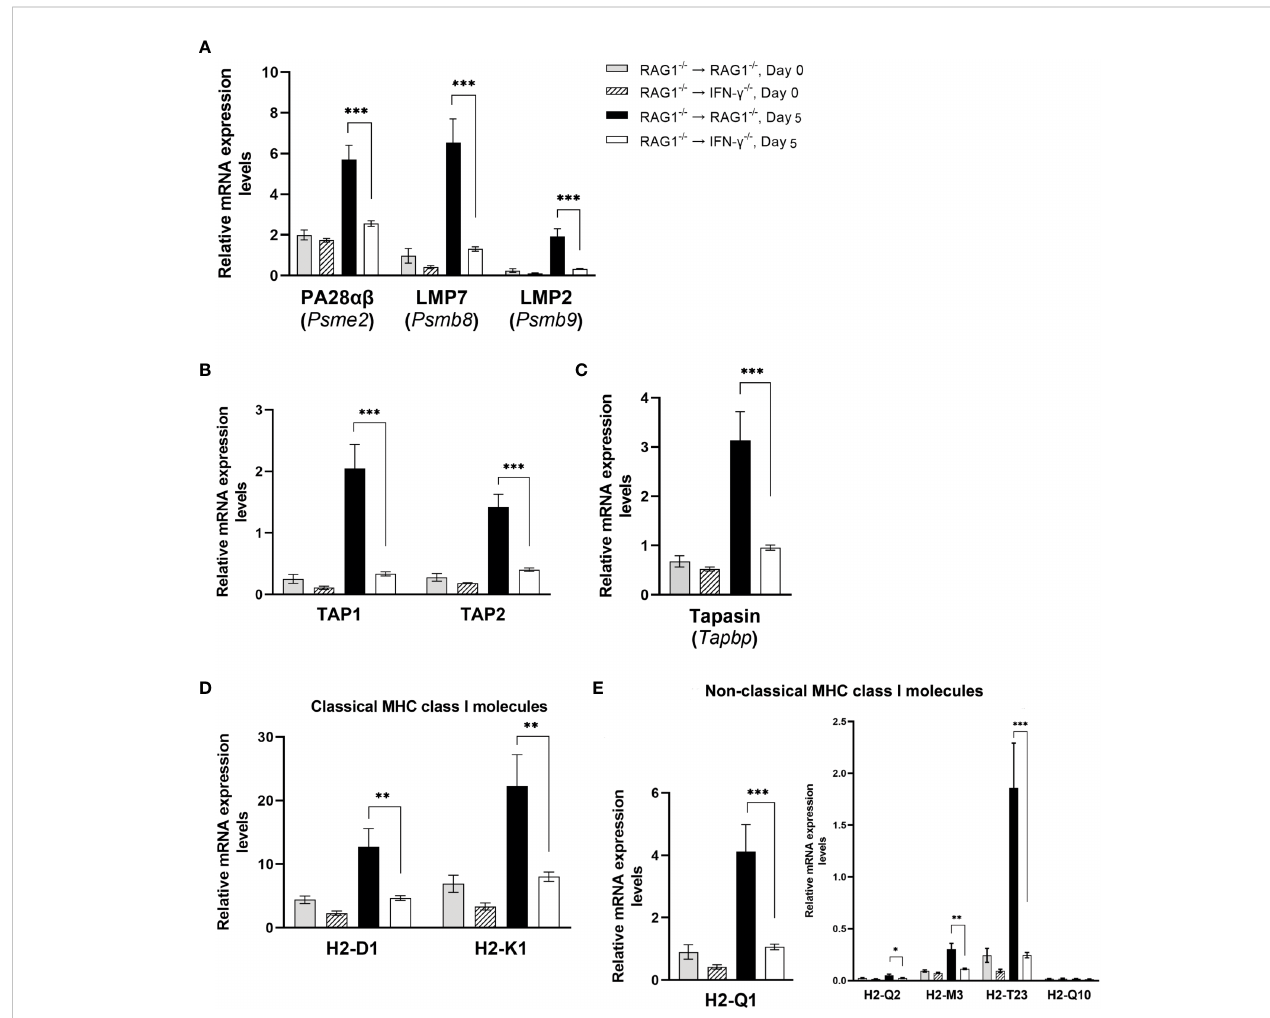
FIGURE 6 Cerebral mRNA levels for the molecule involved in processing, transporting, and presentation of antigens through the MHC class I molecules for activating CD8 + T cells are upregulated by IFN- g production by brain-resident cells during reactivation of cerebral T. gondii infection. For the details of experimental methods, see the legend of Figure 1. The mRNA levels for the molecules for (A) antigen processing and peptide generation, (B) Peptide transport, (C) assembling peptide-MHC class I complex, and (D , E) presenting the peptides by classical MHC class I molecules (D) and non-classical MHC class I molecules (E) to activate CD8 + T cells were measured at both Day 0 and Day 5 in the brains of both groups of mice were measured using NanoString nCounter Mouse Myeloid Innate Immunity Panel. * P <0.05, ** P <0.01, and *** P <0.001. The data were combined from two independent experiments (n=5 for Day 0 and n=7 for Day 5 in both RAG1 -/- → RAG1 -/- and RAG1 -/- → IFN- g -/-